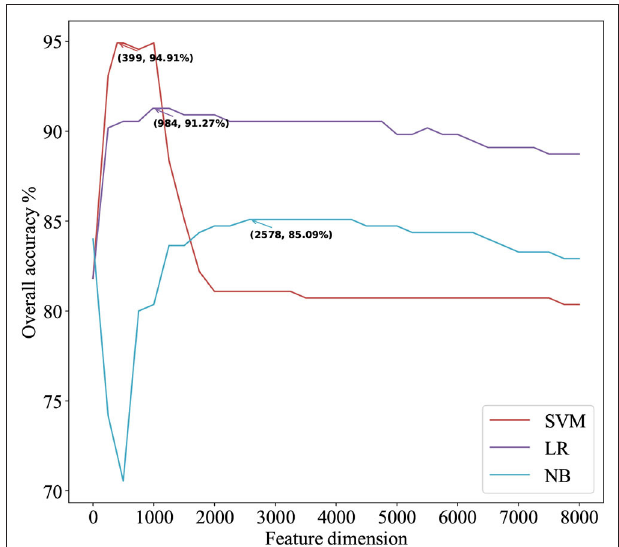
FIGURE 2 | The IFS curve for predicting mitochondrial proteins of Plasmodium using three classifiers. The accuracies of the SVM classifier and the LR classifier improve when the number of features is initially increased. When the number of features exceeds 399, the accuracy of the SVM classifier decreases significantly and finally returns to stable. With the increase in the number of features, the accuracy of the NB classifier first decreases significantly and then gradually increases to